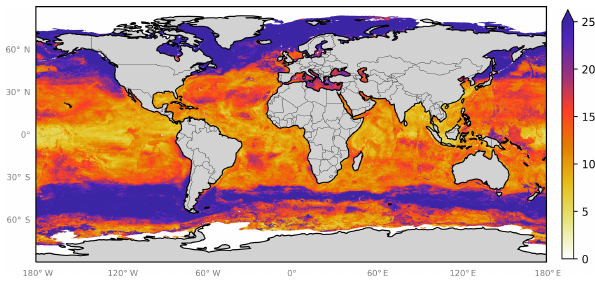
Figure 8. Annual average spatial percent uncertainty in predicted sea-surface iodide for the ensemble of models. Percent spatial un- certainty was calculated as the standard deviation in monthly av- erage values for all models, divided by the annual mean. Values are limited to 25% for contrast, but the maximum plotted value is 77% in the northern high latitudes. Only locations that are en- tirely water are included in the spatial average. Earth raster and vector map data used are freely available from Natural Earth (http: //www.naturalearthdata.com/, last access: 23 July